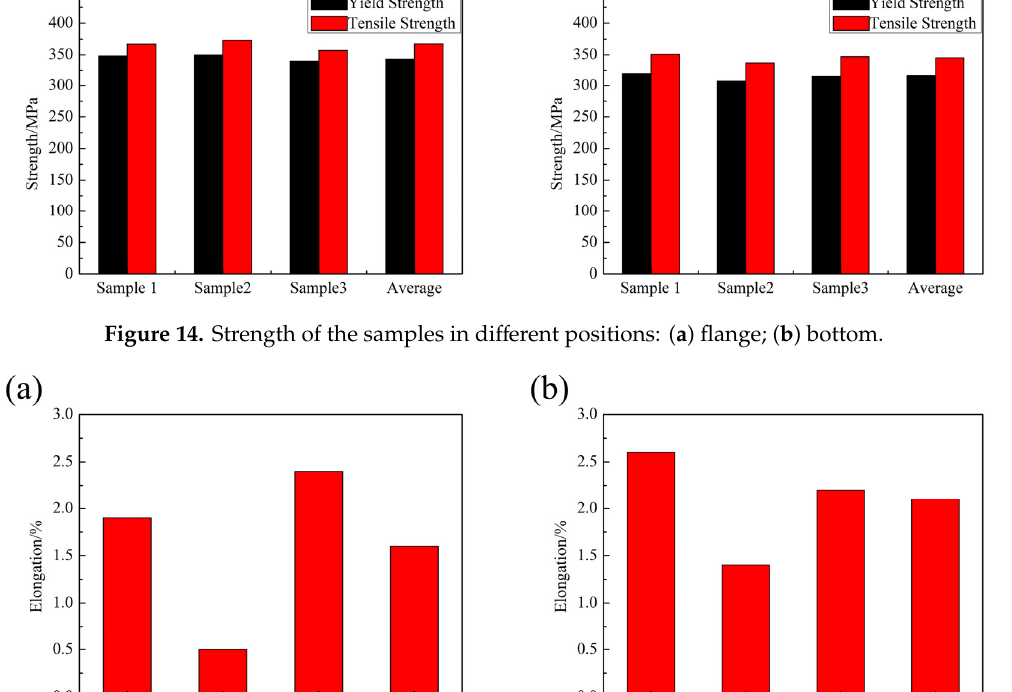
Figure 15. Elongation of the samples in different positions: ( a ) flange; ( b ) bottom.